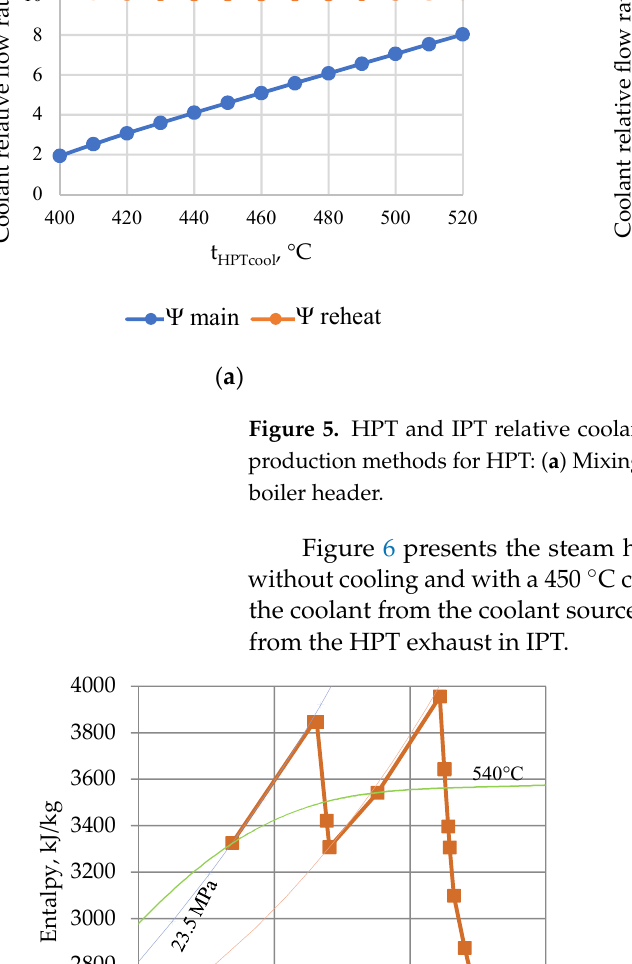
Figure 5. HPT and IPT relative coolant flow rates at different coolant temperatures and coolant pro- duction methods for HPT: ( a ) Mixing of main steam and feed water; ( b ) steam extraction from the boiler header.